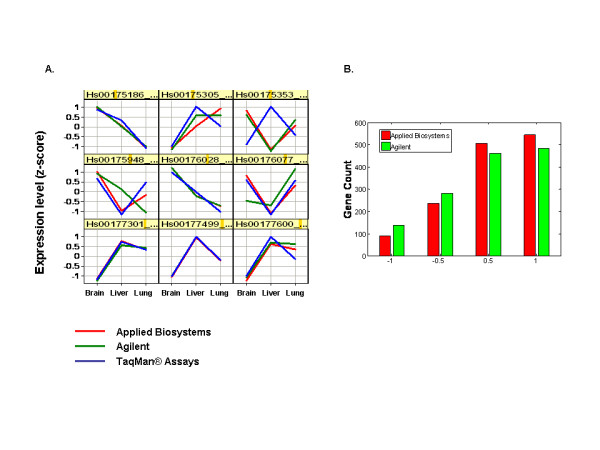
Spearman rank-order correlation of gene expression profiles across all three tissues determined by microarray platforms and TaqMan® Gene Expression Assay based real-time PCR. (A). Example gene expression profiles on 9 genes determined by Applied Biosystems microarrays, Agilent microarrays, and TaqMan Gene Expression Assay based real-time PCR. The gene expression profile for each gene across the three tissues was determined using the median expression level of the four technical replicates followed by a z-score transformation across the three tissues for each of platforms as described in Methods. (B). Distribution of the Spearman rank-order correlation coefficients (r) of profiles determined by each microarray platform vs. real-time PCR.